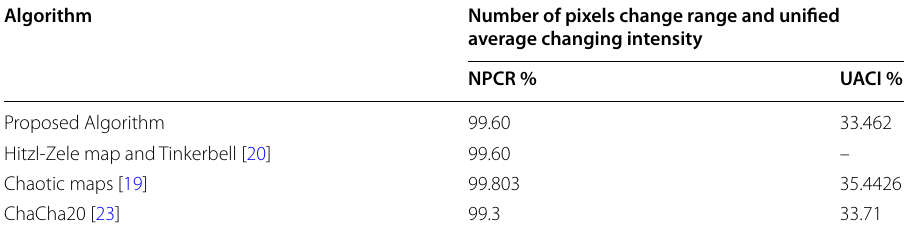
Table 3 The number of pixels changes range and unified average changing intensity Algorithm